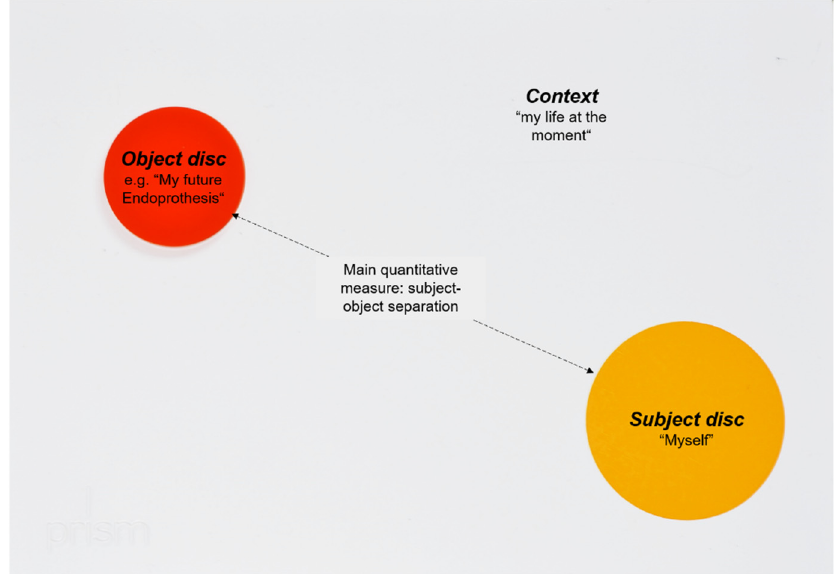
Figure 1. Principle of PRISM. The placement of the objects visualizes the relationship between subject and objects and is able to initiate a reflection process mod. [7].